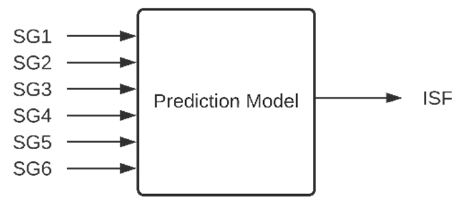
Figure 4. Inputs and outputs of the prediction model.